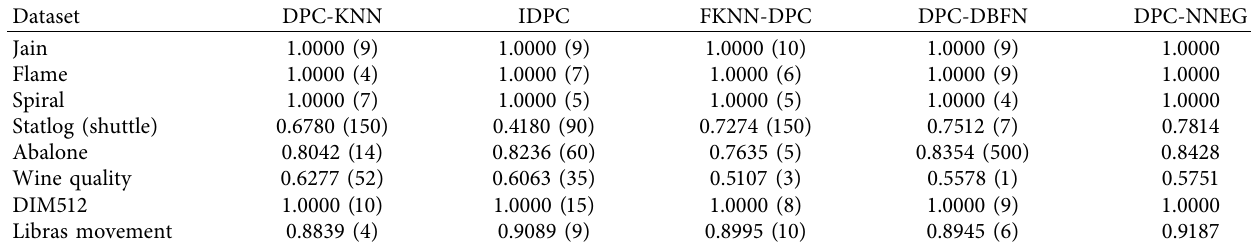
Table 4: Clustering results measured by RI.